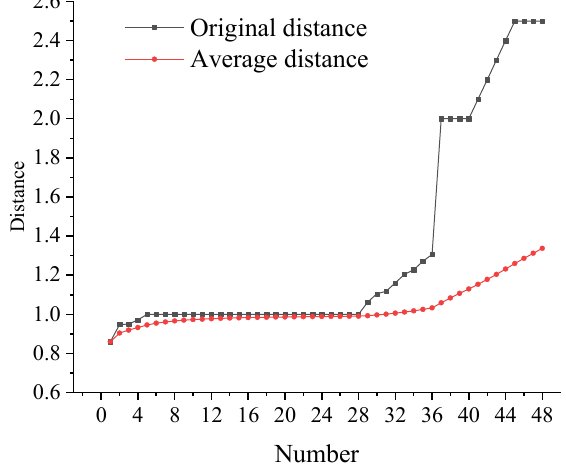
Figure 1. Effect of noise at each scale on the average distance.